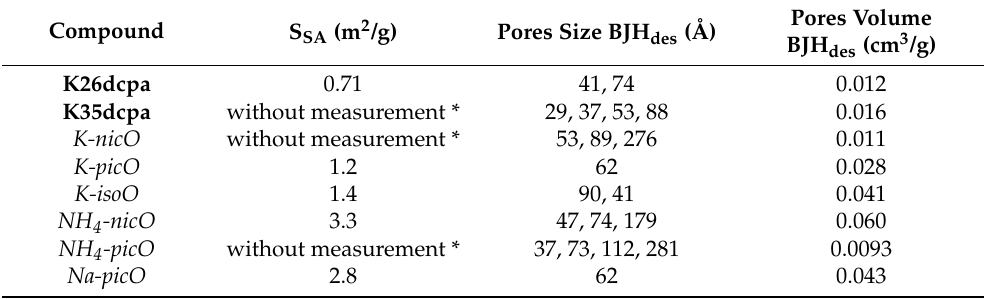
Pores Volume BJH des (cm 3 /g)